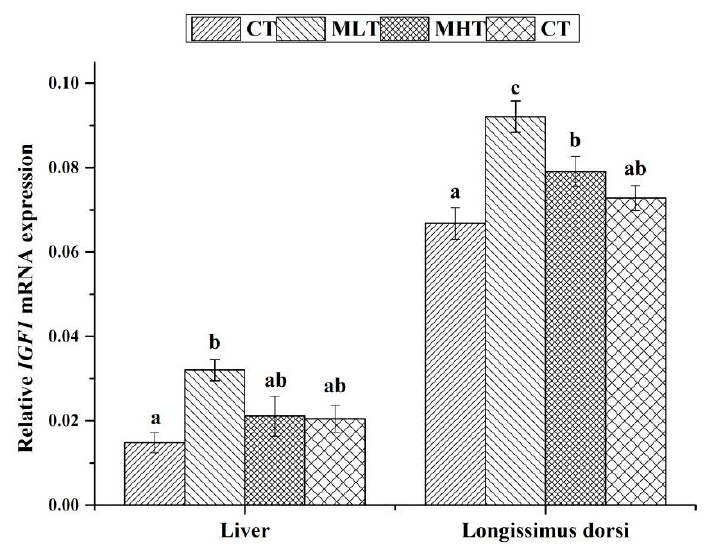
Figure 2. Effects of MLPs on IGF1 mRNA expression in liver and muscle longissimus in weaning pigs. Vertical bars represent standard errors, N = 5. Values are expressed in means. Mean values with different letters ( a, b, c ) are significantly different within a cluster of bars, not across clusters of bars ( P < 0.05).